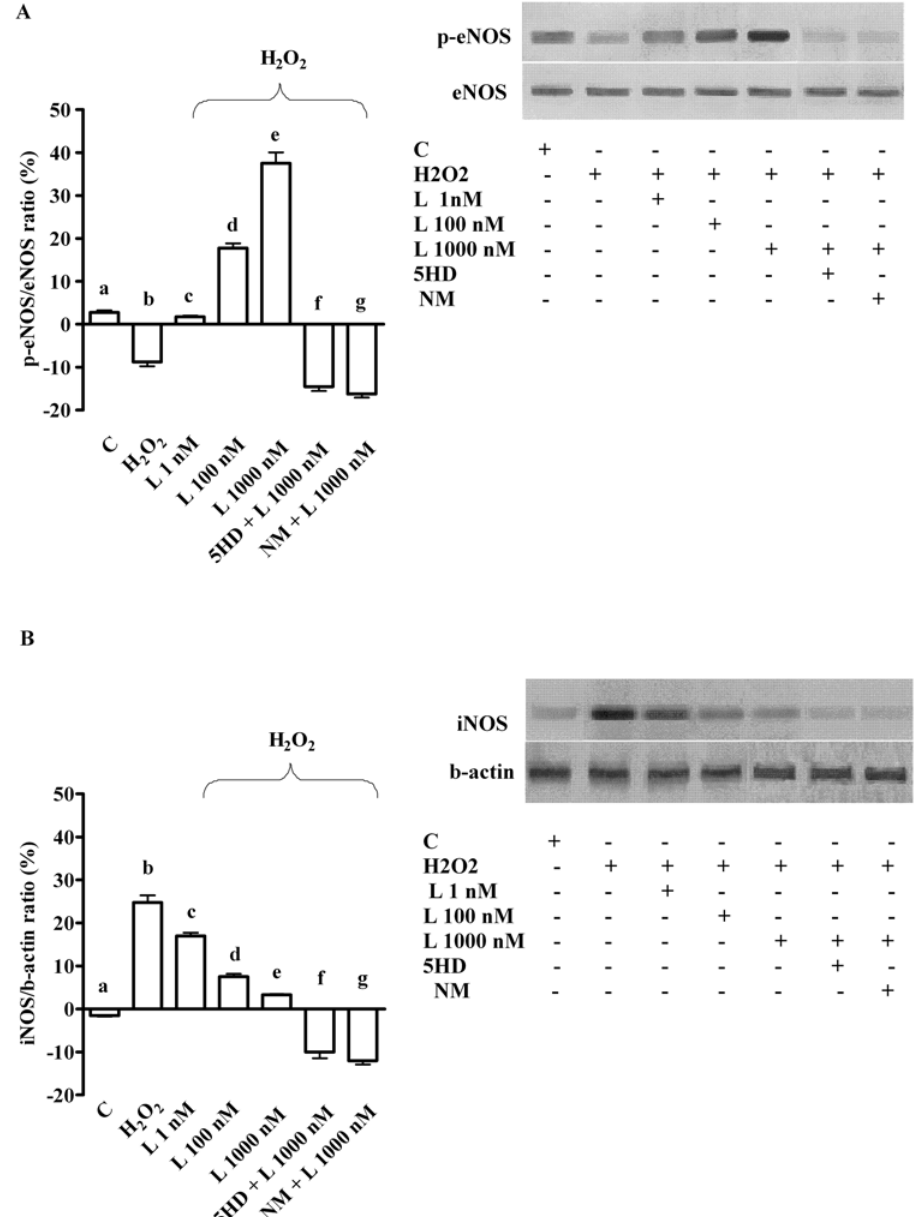
Fig 5. Effects of levosimendan on eNOS (A) and iNOS activation (B) in hepatocytes subjected to peroxidation. In A and B, densitometric analysis of p-eNOS and iNOS and an example of lanes taken in one of 5 different experiments performed for each experimental protocol. eNOS = endothelial nitric oxide isoform; iNOS = inducible nitric oxide isoform; L = levosimendan; NM = L-NAME. The other abbreviations are as in Figs 1 – 4. In A, b, d, e, f, g P < 0.05 vs a; c, d, e, f, g P < 0.05 vs b; d, e p < 0.05 vs c; d, f, g P < 0.05 vs e. In B, b, c, d, e, f, g P < 0.05 vs a; c, d, e, f, g P < 0.05 vs b; d, e P < 0.05 vs c; d, f, g P < 0.05 vs e. The results of densitometric analysis are expressed as means of 5 independent experiments (%) ± SD (indicated by the bars).